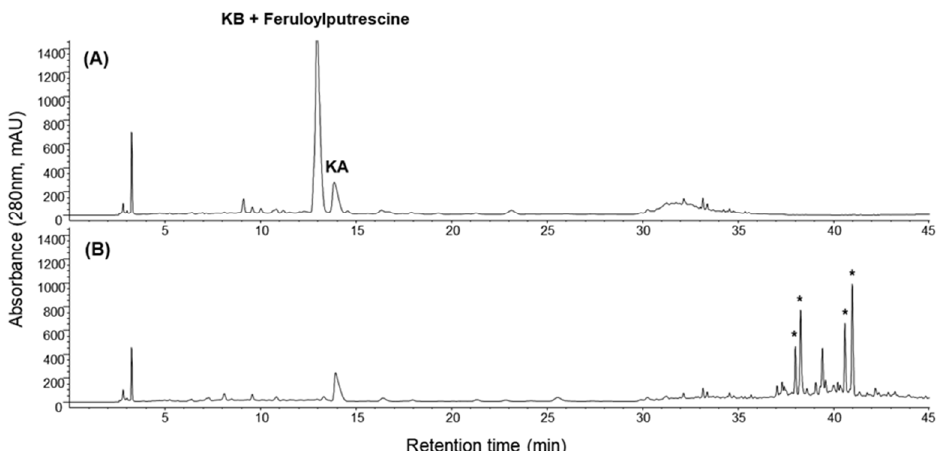
Figure 2. The HPLC chromatogram obtained for ( A ) the LRC extract (100 mg/mL) after incubation with ( B ) trans -2-nonenal in PBS (100 mM, pH 7.4) at 37.5 °C for 72 h. The peaks designated as asterisk (*) were new product peaks that appeared throughout this reaction.